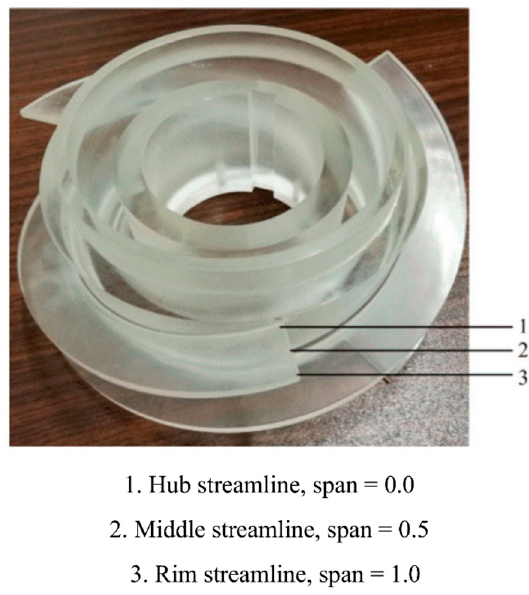
J. Mar. Sci. Eng. 2022 , 10 , x FOR PEER REVIEW Figure 7. Streamlines on the blade surface. Figure 7. Streamlines on the blade surface.